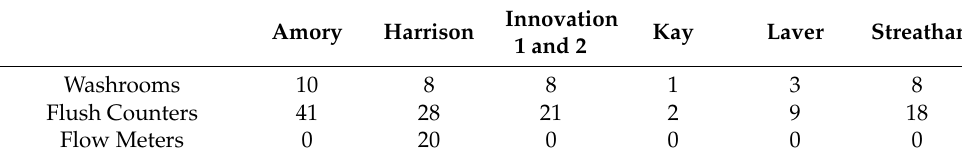
Table 1. Summary of water meter data collection installed within the